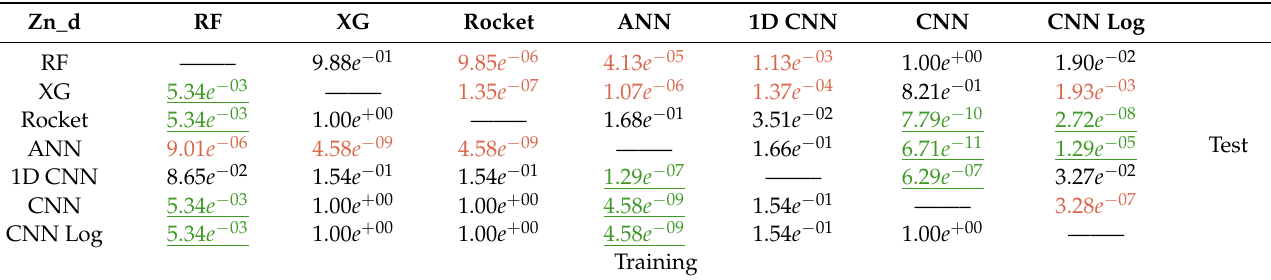
Table A13. Kruskal–Wallis p -values comparing all methods of the Zn_d concentration prediction task. Above the diagonal, we have the results for the test set, and below for the training set. Significant results ( p < 0.01) are represented in green or red when the method on the left is significantly better or worse, respectively.